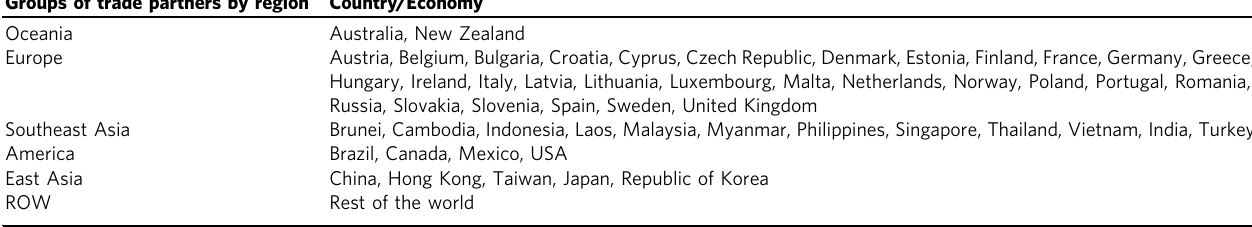
Table 1 Trade partners identi fi ed in PV product trade fl ow matrix (TFM). Groups of trade partners by region Country/Economy Oceania